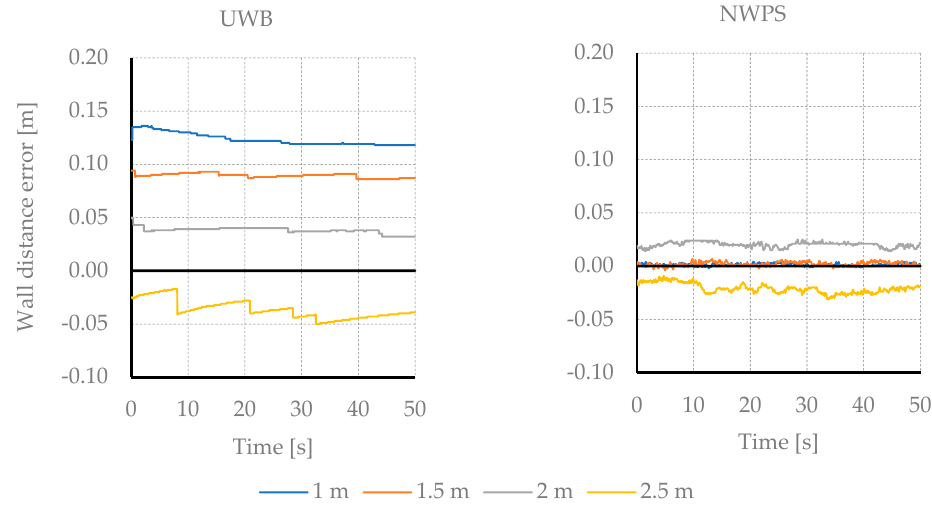
Figure 4. Results of the estimation of the distance to the wall in the static tests. Comparison between the Ultra-wideband (UWB) and the proposed Near-Wall Positioning System